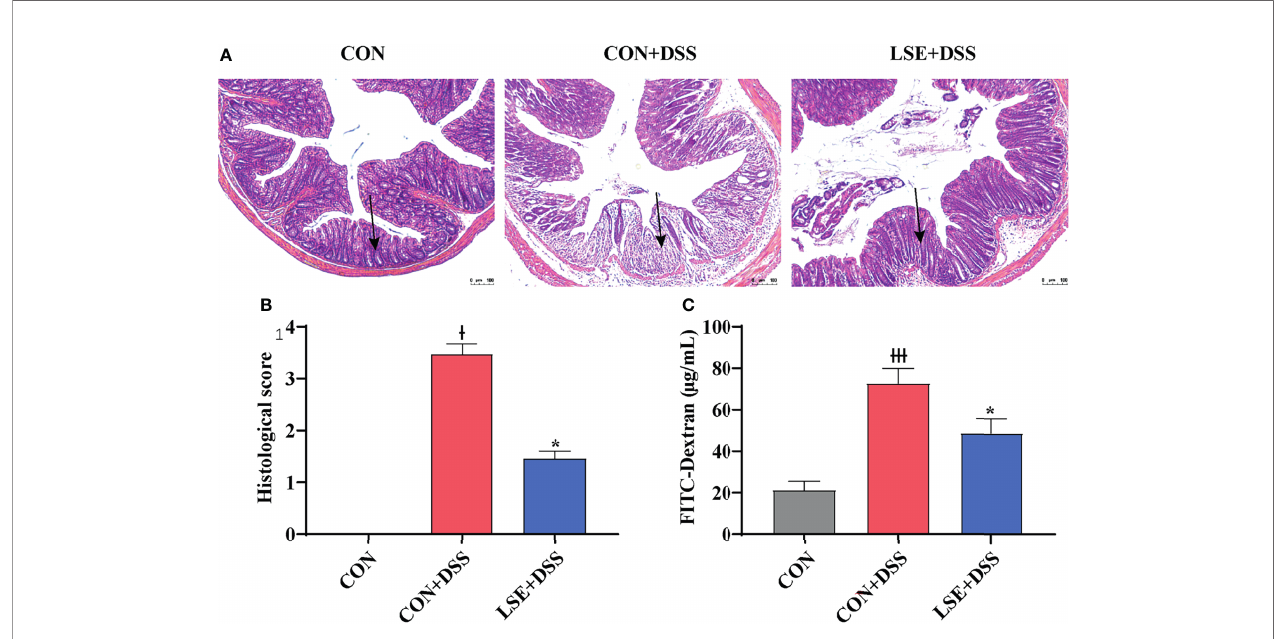
FIGURE 2 | Effects of LSE supplementation on histopathological changes in DSS-induced mouse colon. (A) H&E staining images of each group. (B) Histopathological score of each group. (C) Serum FITC-dextran levels of each group. Data are presented as mean ± SEM, n = 4. * P < 0.05 vs. the CON+DSS group, † P < 0.05 vs. the CON group, and ††† P < 0.001 vs. the CON